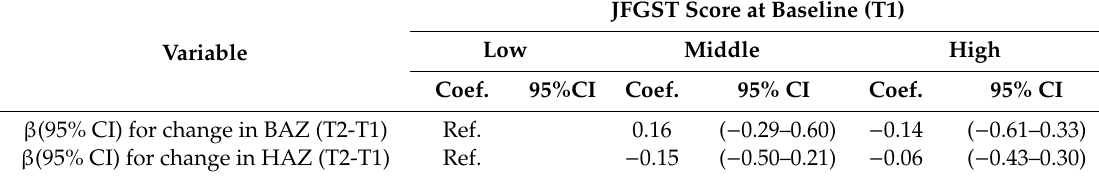
Table 4. Association between Japanese Food Guide Spinning Top score at baseline (T1) and change in BAZ and HAZ (T2-T1). JFGST Score at Baseline (T1) Low Middle High Variable Coef. 95%CI Coef. 95% CI Coef. 95% CI β (95% CI) for change in BAZ (T2-T1) Ref. 0.16 ( − 0.29–0.60) − 0.14 β (95% CI) for change in HAZ (T2-T1) Ref.